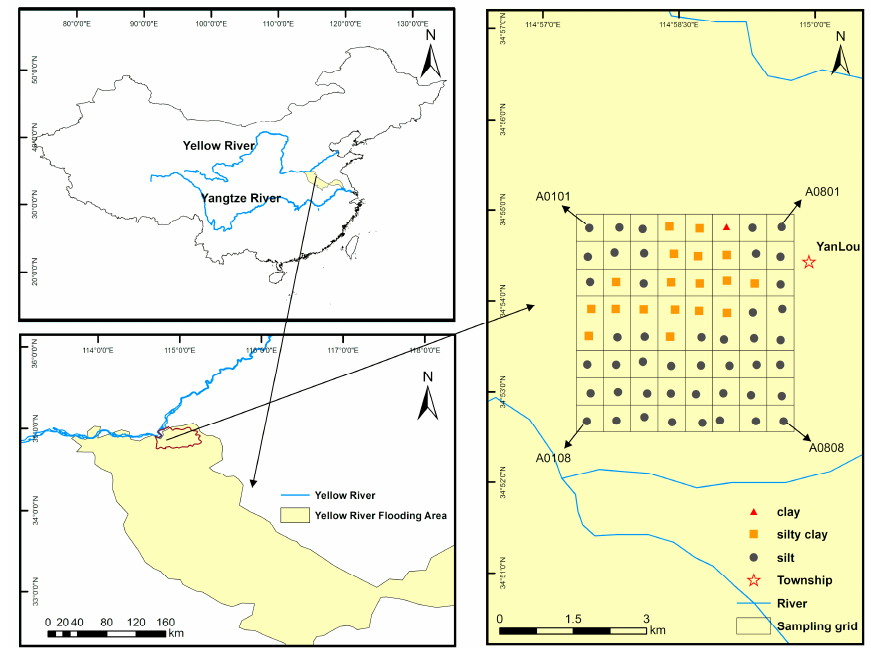
Figure 1. Distribution of the study area and sampling points.